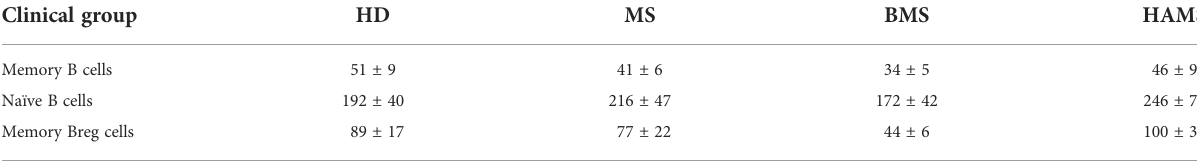
TABLE 3 Total numbers of B cell subpopulations in peripheral blood of the MS patients and healthy donors (gating strategy is shown in Figure 4 ). Clinical group HD MS BMS HAMS